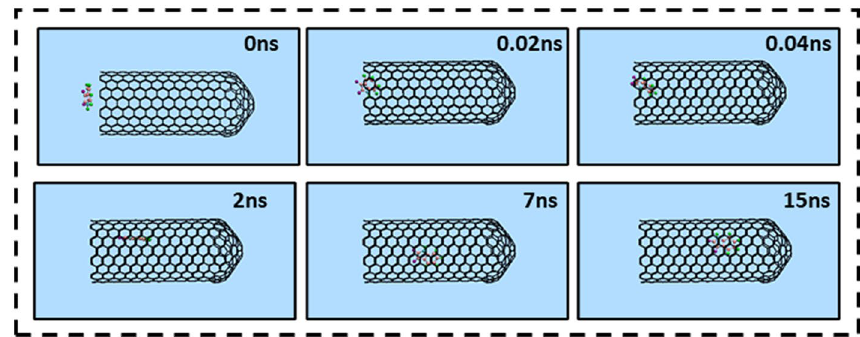
Figure 2. Representative snapshots of insertion of a single molecule of Isatin into an armchair capped SWCNT (10,10) host at various times. For clarity, the water molecules have been omitted from the image.